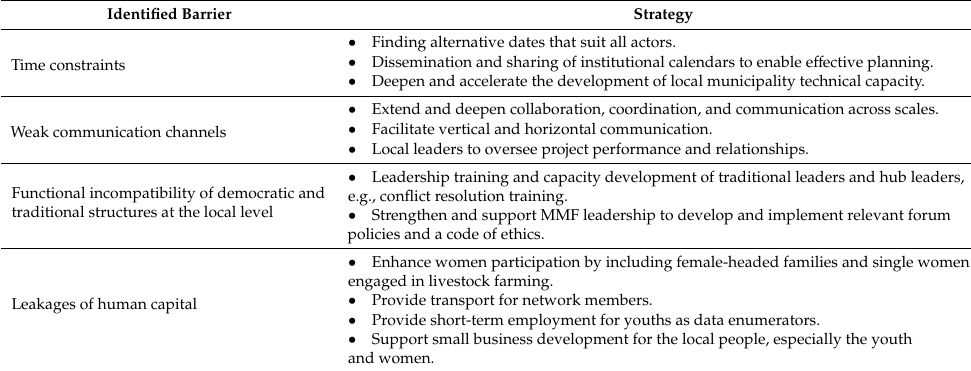
Table 2. Identified strategies to overcome barriers to e ff ective collaboration and coordination in transformative